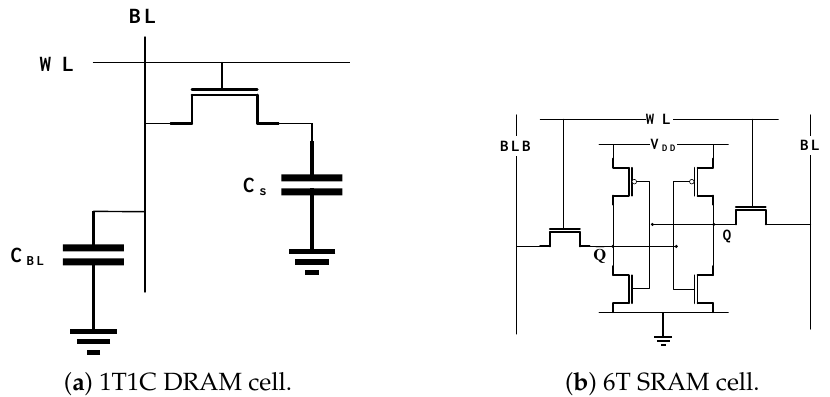
Figure 6. Examples of typical ( a ) DRAM and ( b ) SRAM cell